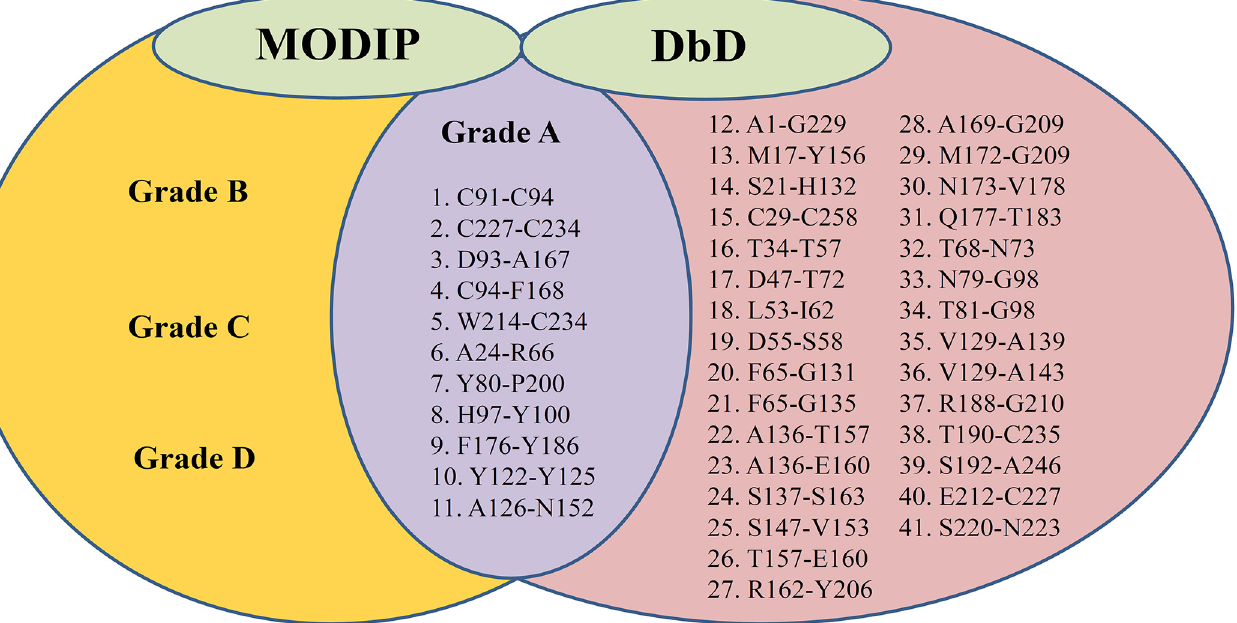
Fig 2. Alignment of amino acid sites for disulfide bridges predicted by MODIP and DbD. The amino acid sites predicted by DbD are shown in the right (pink) oval. The amino acid sites predicted by MODIP are shown in the left (yellow) oval. The middle (purple) oval shows 11 amino acid sites predicted by both DbD and MODIP that have the highest possibilities of disulfide bridge